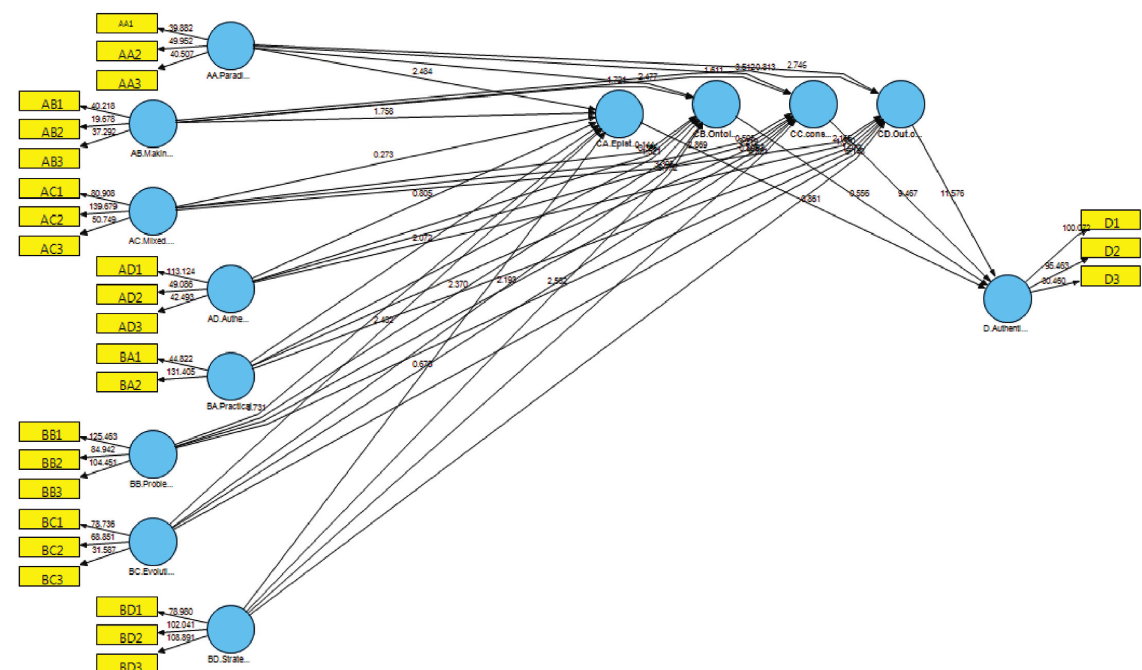
Figure 5: The external model of second-order hypotheses in the general significance